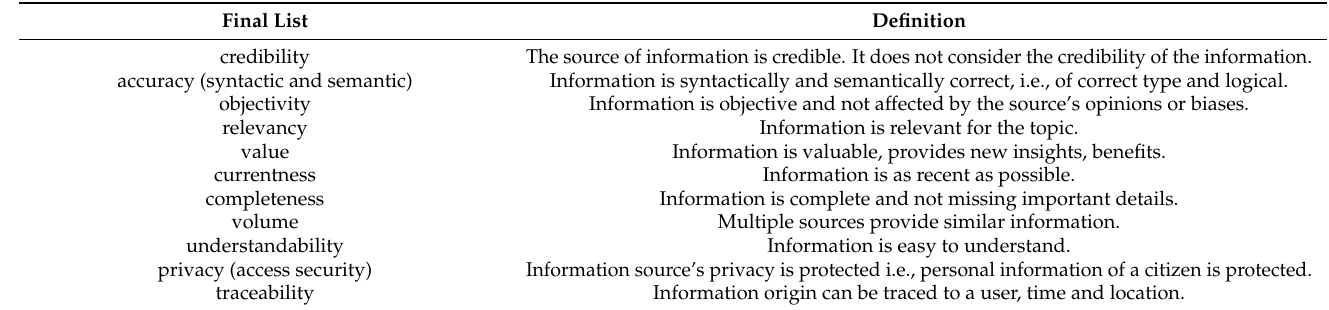
Table 2. Chosen characteristics and their